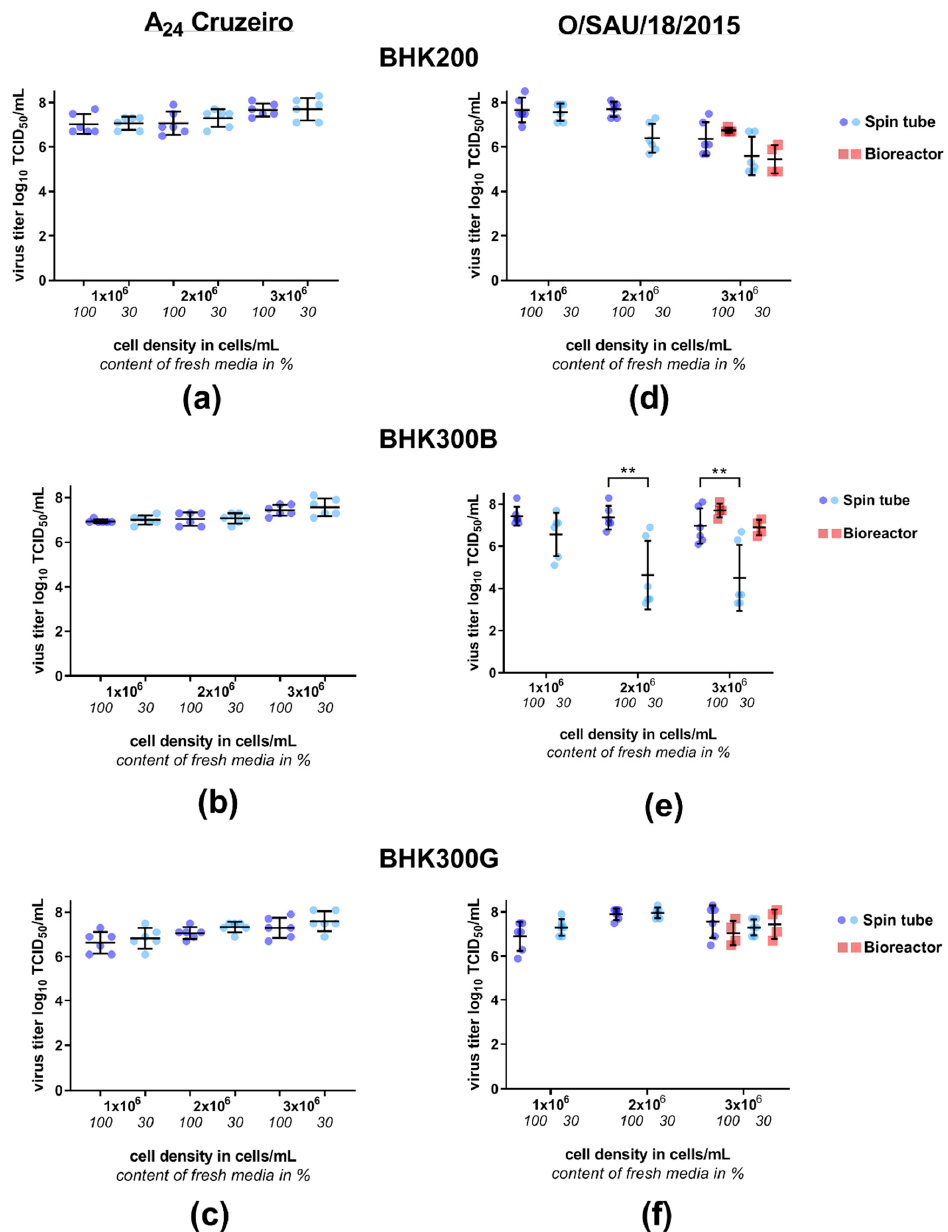
Figure 2. Cell density experiments in spin tubes and 3L-single-use bioreactors with different cell culture media for cell growth. Cells were grown in ( a, d ) the animal-component-free (ACF) media BHK200 or in the CDM ( b, e ) BHK300B and ( c, f ) BHK300G in three different cell densities (1 × 10 6 / 2 × 10 6 / 3 × 10 6 cells/mL). A media exchange of either 100% or addition of 30% fresh media was performed before infection with FMDV A24 Cruzeiro (panels a–c ) or O/SAU/18/2015 (panels d–f ) at a MOI of 0.01. The final virus titers in log 10 TCID 50 /mL of the spin tube experiments are colored in blue, while the results of the bioreactor runs are shaded in red. Significance code: “**” p ≤ 0.01.